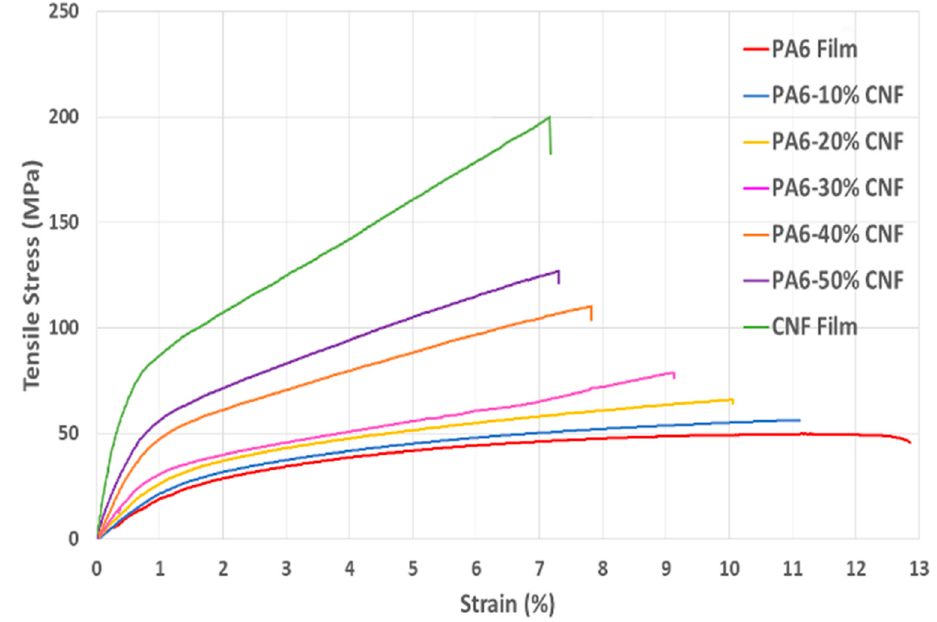
Figure 2. Stress vs. strain curves for control samples and PA6-CNF nanocomposites.